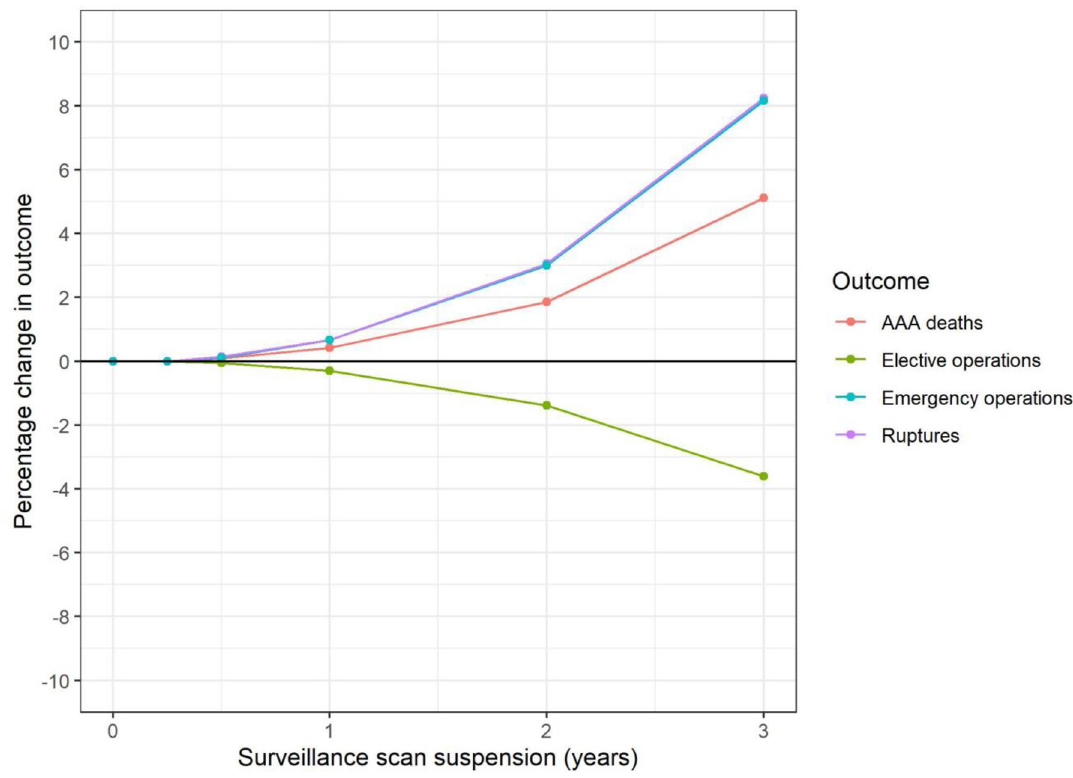
Fig 3. Surveillance cohort: Change in key outcomes over varying suspension of surveillance scans (model